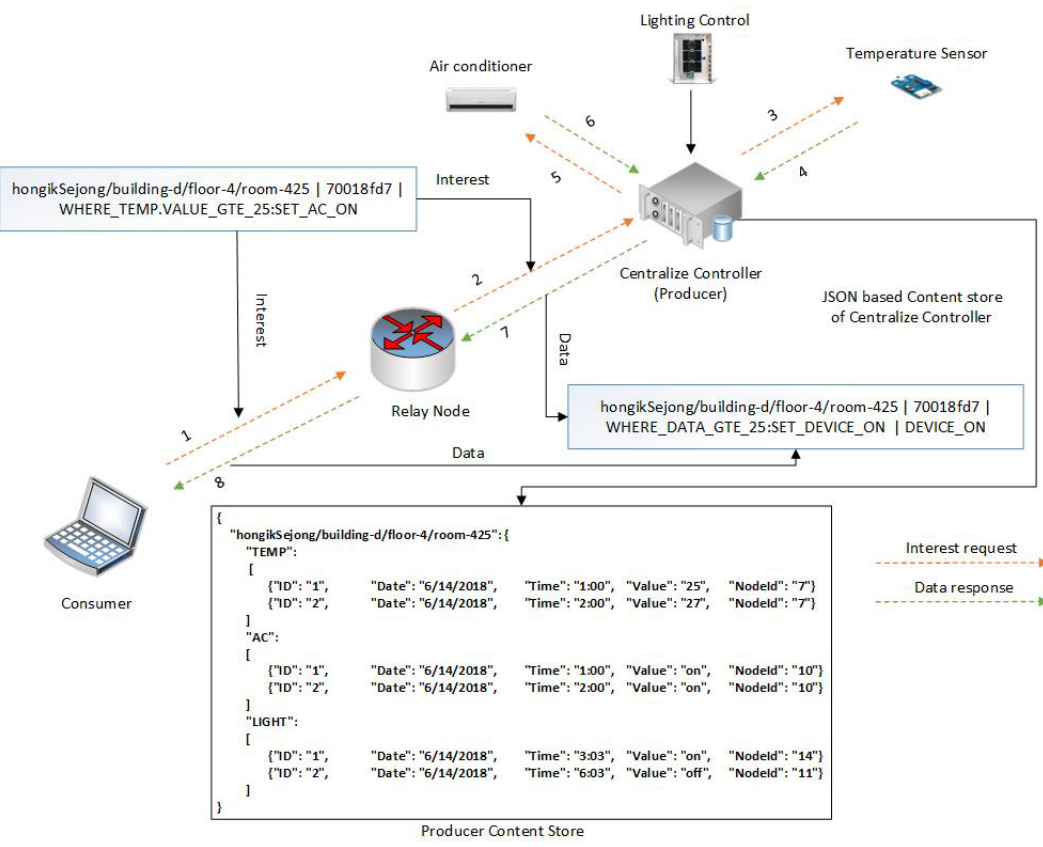
Figure 6. Pull (command) service